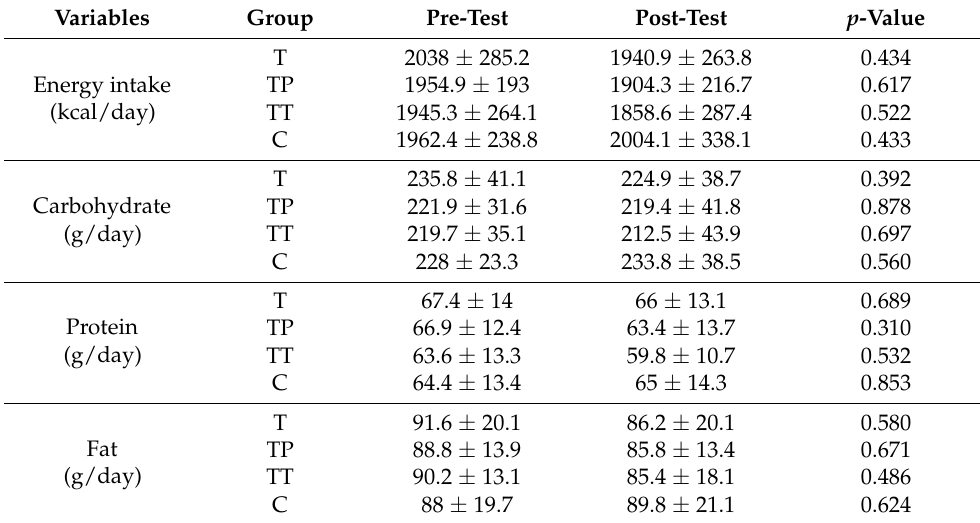
Table 4. Energy and macronutrients at the baseline and at the end of 8